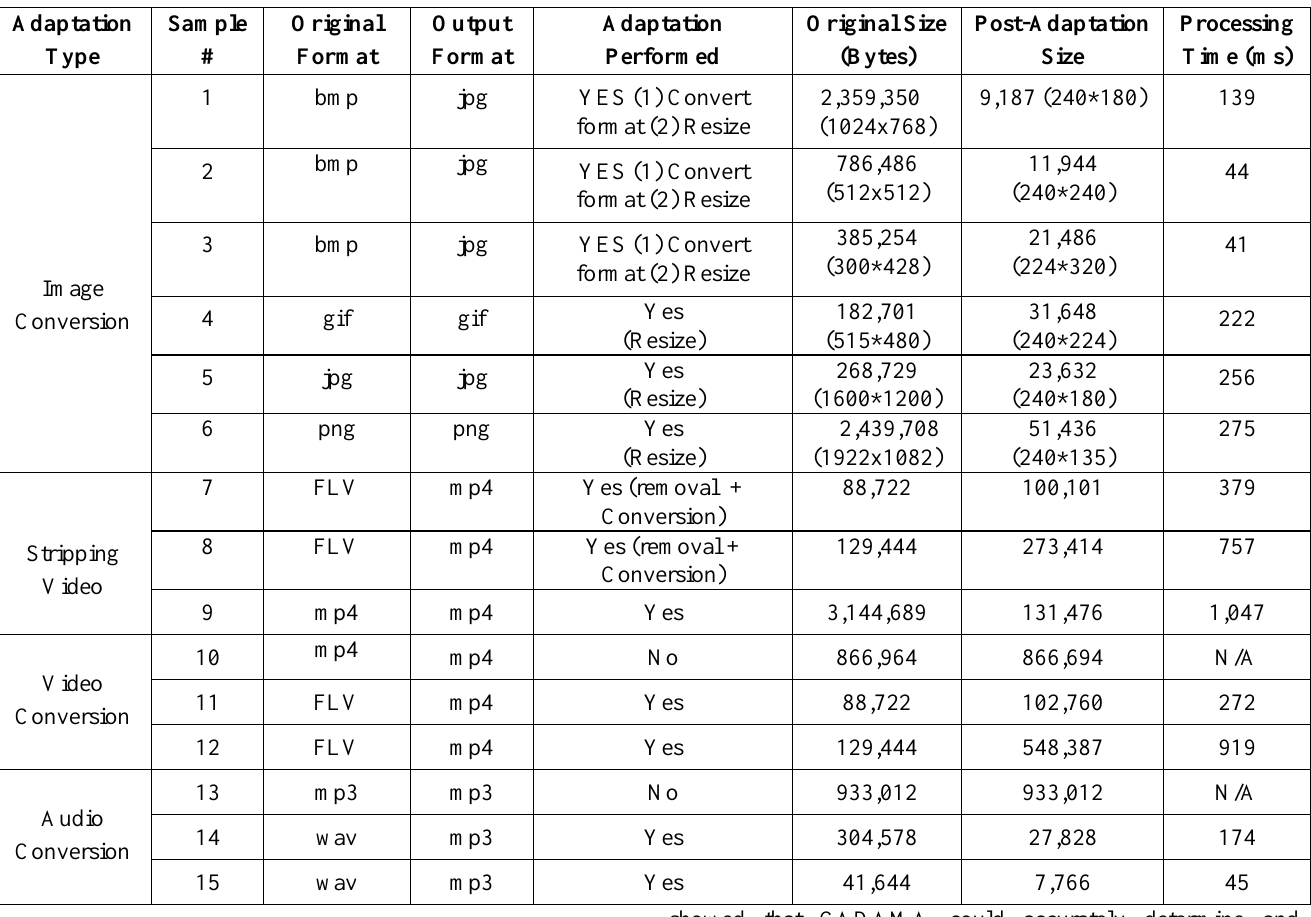
Table I. Results of